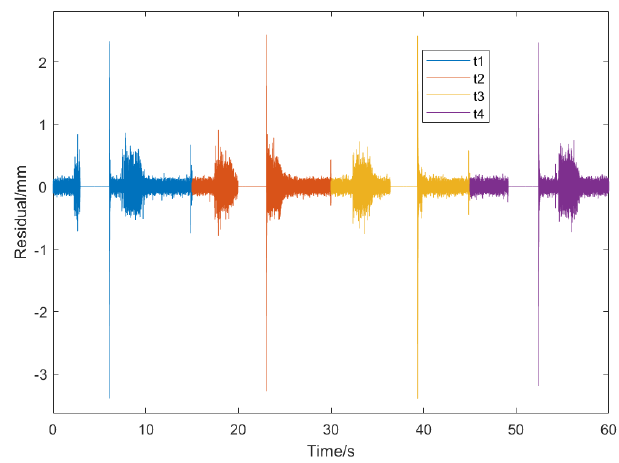
Figure 10. Gap at four moments.